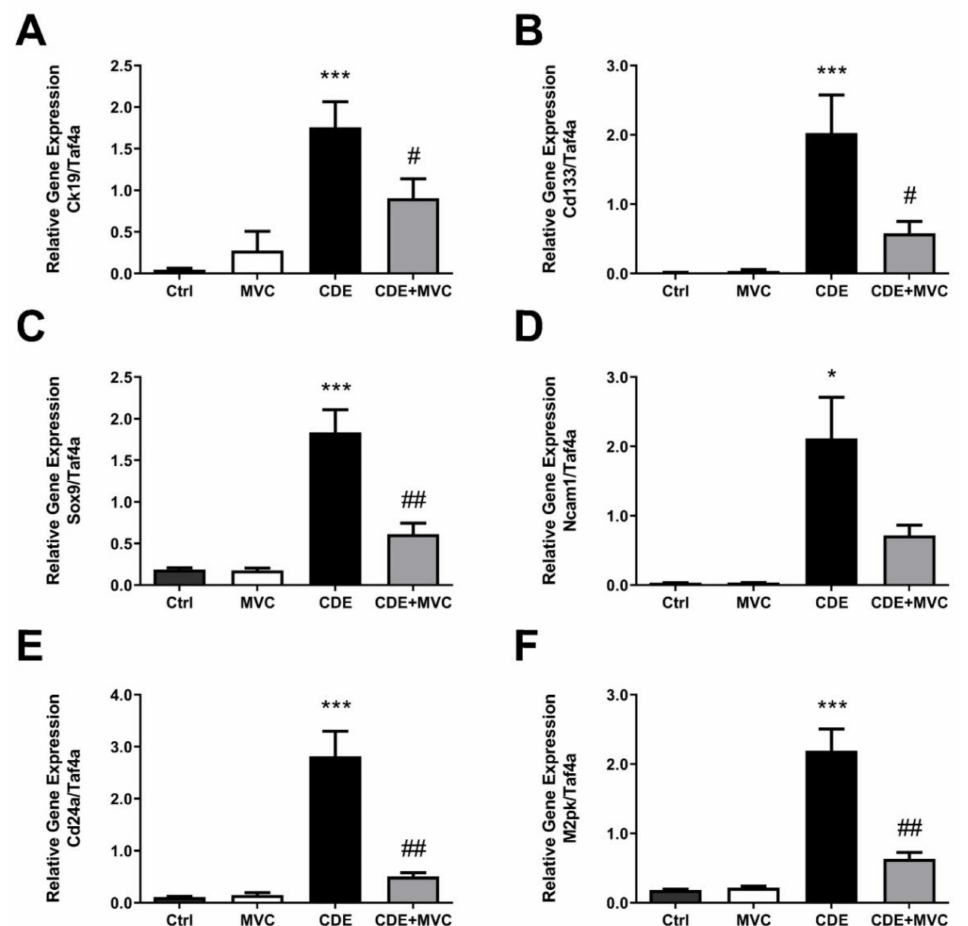
Figure 2. The mRNA expression of LPC markers is attenuated by MVC in CDE liver. ( A – F ) Quantita- tive PCR was performed using cDNA from the livers of animals in the 16-wk control, MVC, CDE, and CDE+MVC groups to amplify genes associated with oval cells. Expression levels are shown relative to the housekeeping gene, TaF4a. Bars represent means + SEM for 7 animals per group. * p < 0.05, *** p < 0.001 compared to ctrl. # p < 0.05, ## p < 0.01 compared to CDE